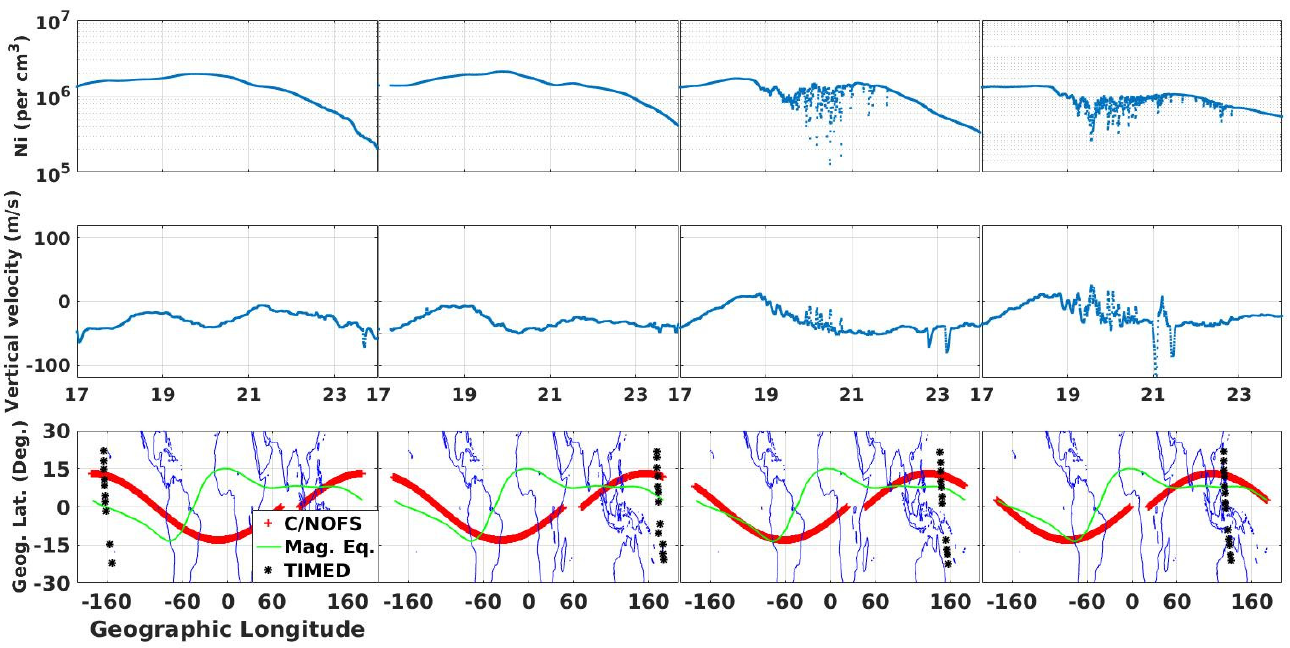
Figure 2. Irregular ion density ( top row ) and plasma vertical drift velocity ( middle row , positive and negative values represent upward and downward, respectively ) from C/NOFS and coordinates of data from C/NOFS and SABER satellites ( bottom row ) versus LT on 16 October 2011.